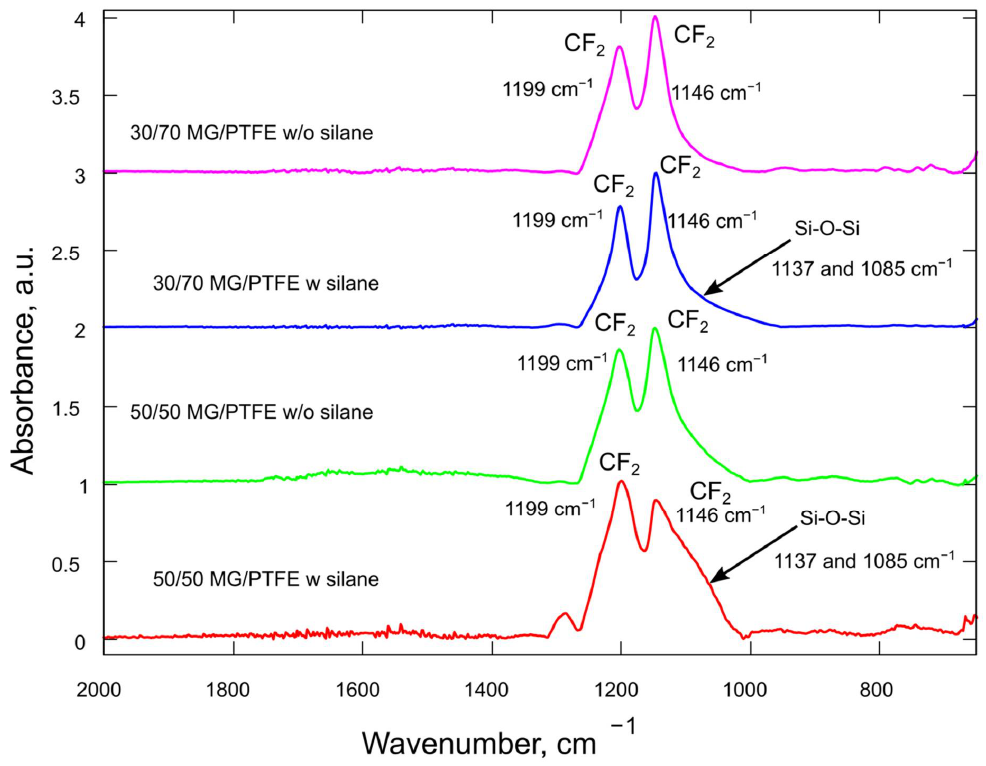
Figure 6. FTIR spectrum of 30/70 composite (without silane), 30/70 composite (silane), 50/50 composite (without silane), and 50/50 composite (silane).